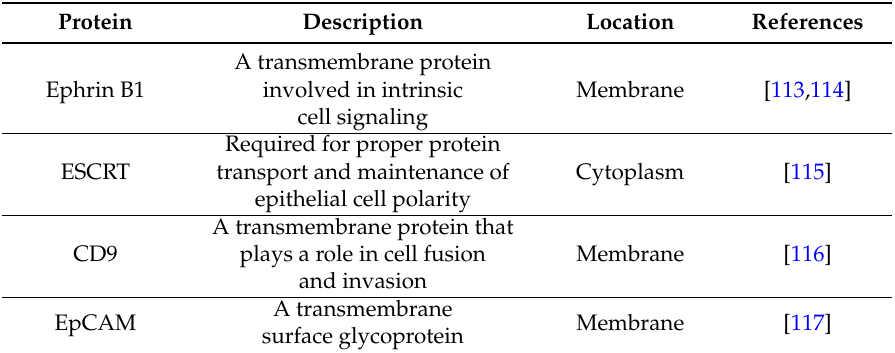
Table 1. Putative interacting partners of claudin 1 in breast